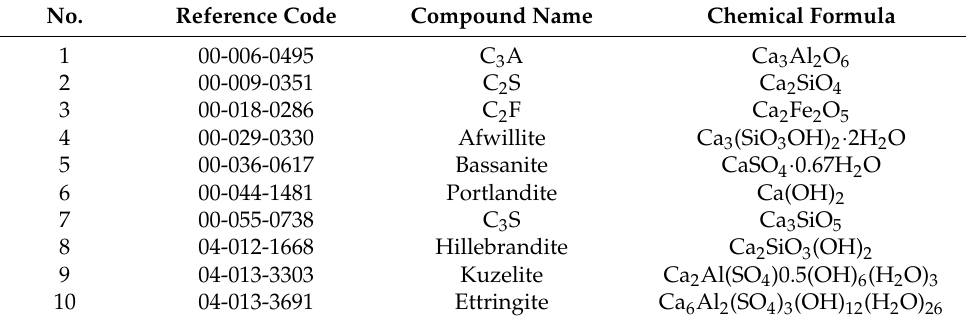
Figure 8. X-ray patterns of all samples after 2, 7, 14, and 28 days of curing time. Table 4. Identified crystalline phases for all samples.